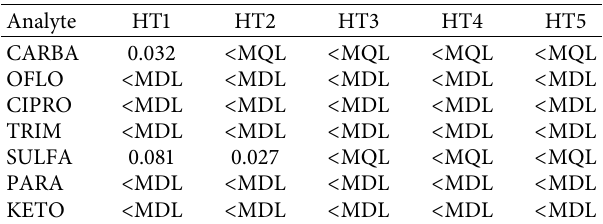
Table 5: Concentration of target pharmaceutical residues ( µ g L − 1 ) in surface